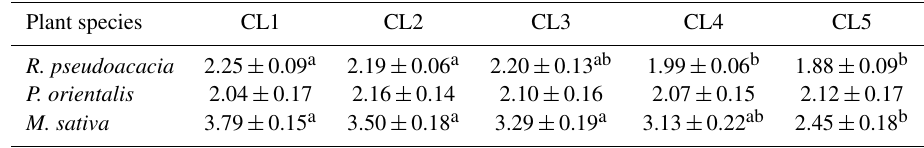
Table 5. Average leaf water contents of plants growing in the compacted LGM (gg − 1 ) .